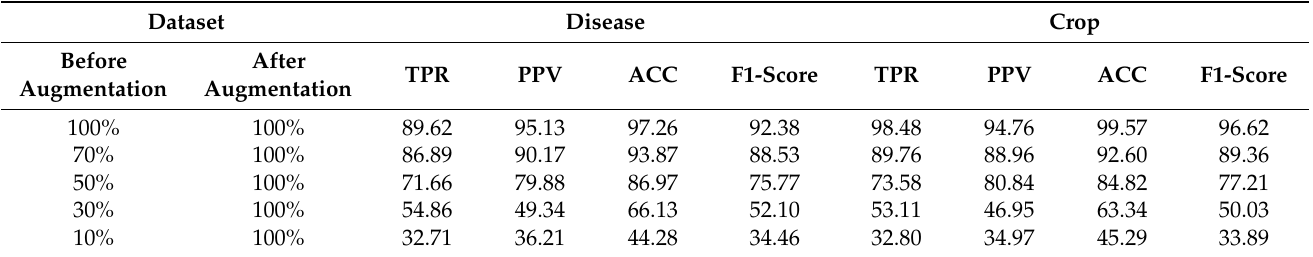
Table 19. Comparison of accuracies achieved by the proposed PI-CNN in the original and augmented datasets. The accuracies were achieved in the PlantVillage dataset (unit: %).